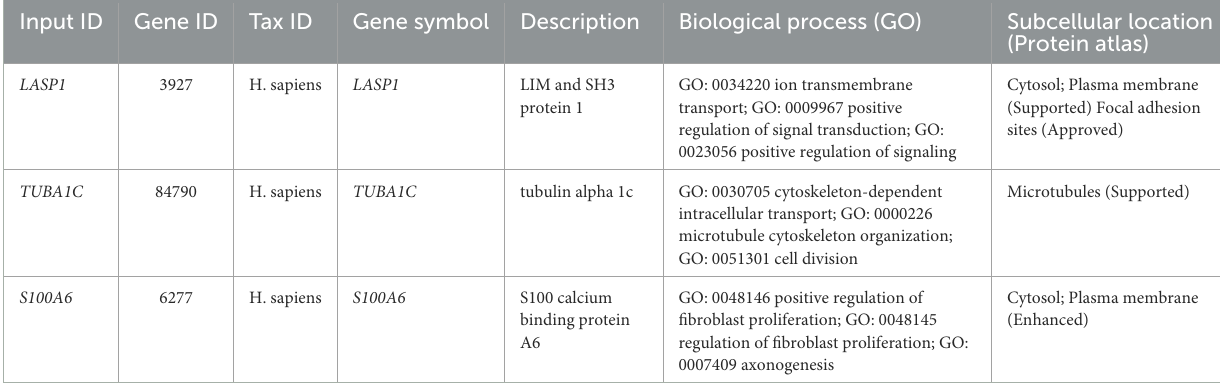
TABLE 5 Metascape results LASP1, TUBA1C, and S100A6 genes.